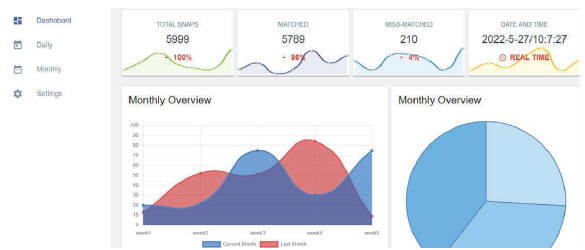
Figure 6: Dashboard design with real-time